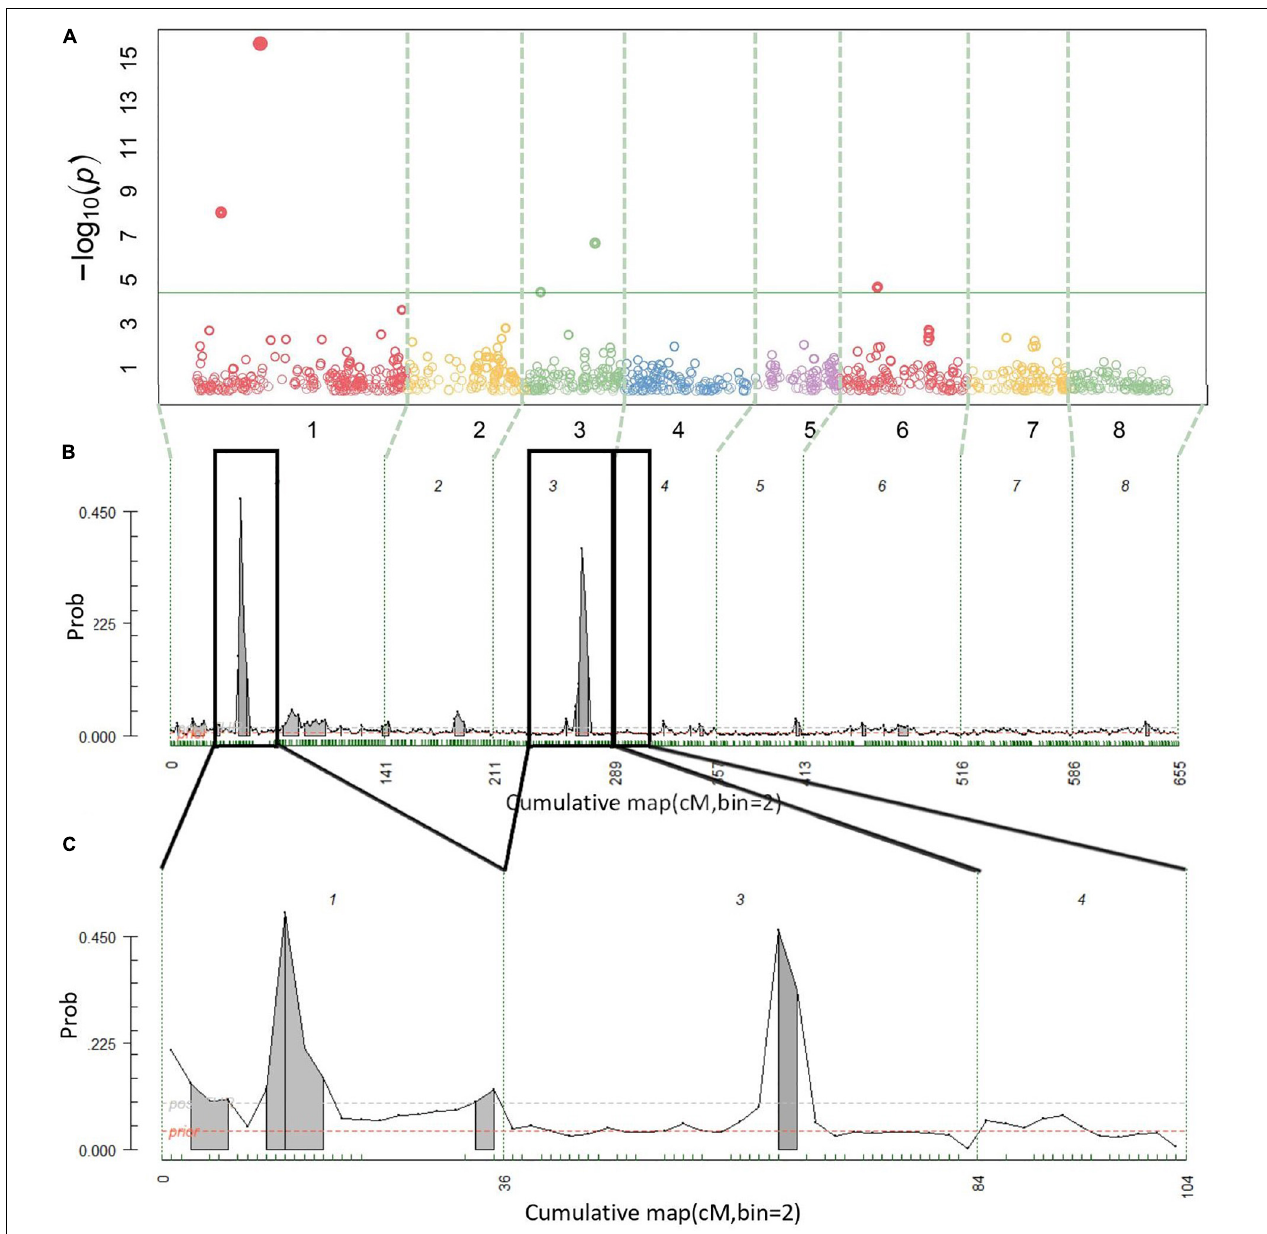
FIGURE 3 | Multiyear firmness QTL detection results. Manhattan plot from BLINK (A) , posterior probabilities of QTL positions from FlexQTL TM full genetic map analysis (B) , and FlexQTL TM reduced map analysis (C) . Dashed vertical lines (A–C) demarcate the chromosomes. Colored circles in (A) represent individual SNPs, their height corresponding to the degree of association between variation in SNP genotype and trait variation. The green horizontal line in (A) indicates a Bonferroni adjusted p -value of 0.05. Small green dashes along the horizontal axes in (B,C) indicate SNPs grouped in 2 cM bins. Peaks indicate evidence for a QTL at that genomic location, with an area filled in gray indicating positive QTL evidence. Dark black outlines in (B) indicate approximate intervals from the full genetic map used to create the reduced map in (C) . Results from both FlexQTL TM runs were achieved with an additive-only model.